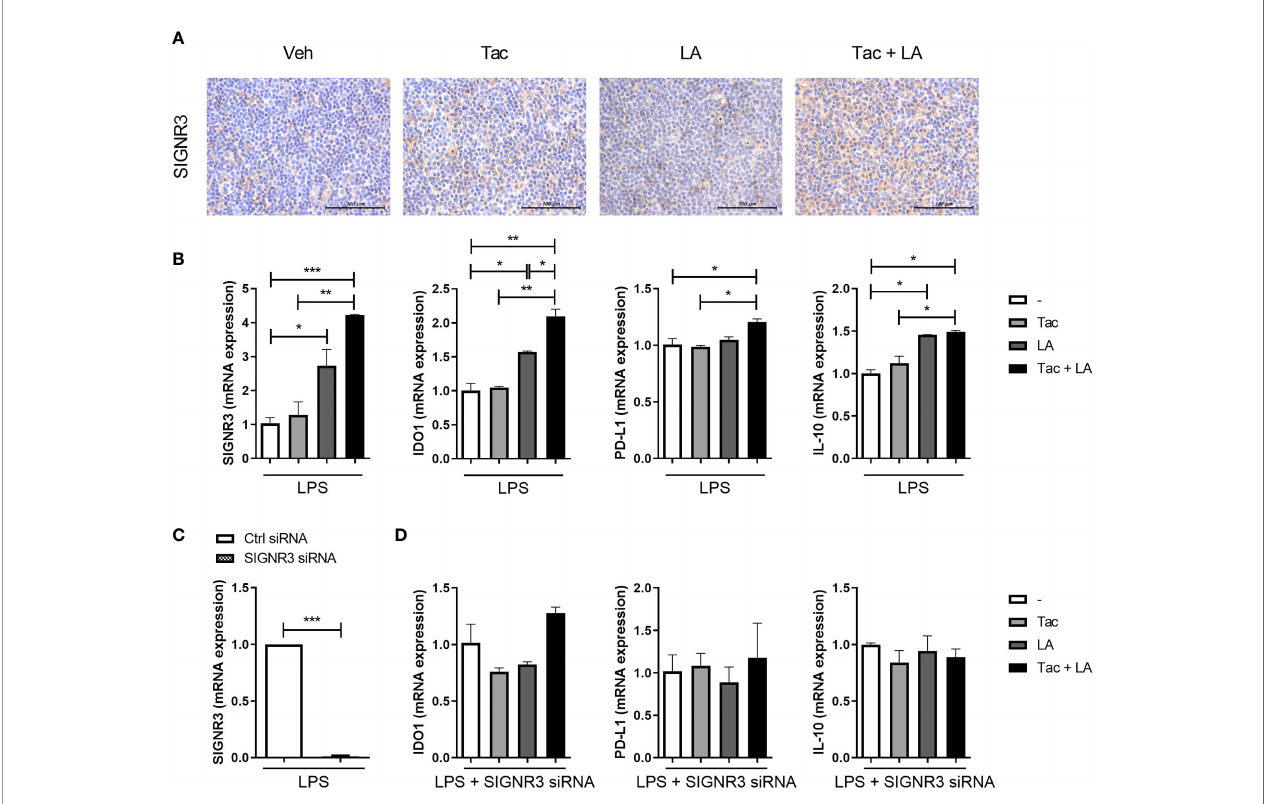
FIGURE 5 | SIGNR3 receptor mediates immune regulation in lupus-prone mice treated with the combination of Tac and LA. (A) Representative pictures of immunohistochemical staining of SIGNR3 in spleen tissues from 16-week-old MRL/ lpr mice treated with the same in vivo experiments shown in Figure 2 (original magni fi cation ×400). (B) Non-T cells from spleens of the mice treated with Tac (0.1 nM) and/or LA (100 m g/ml), were cultured and stimulated with LPS for 24 h. Then, mRNA levels of SIGNR3, IDO1, PD-L1, and IL-10 were determined using real-time PCR (qPCR). (C) Non-T cells from spleens of the mice were transfected with SIGNR3 siRNA after pre-treatment with LPS for 24 h. Expression levels of SIGNR3 mRNA in SIGNR3 siRNA-transfected cells. (D) The siRNA-transfected cells were stimulated with LPS and treated with Tac and/or LA for 24 h. Expression levels of IDO, PD-L1, and IL-10 mRNA, measured by qPCR. All experiments were performed at least three times in triplicate. Data are shown as mean ± SEM. * p < 0.05, ** p < 0.01, *** p <